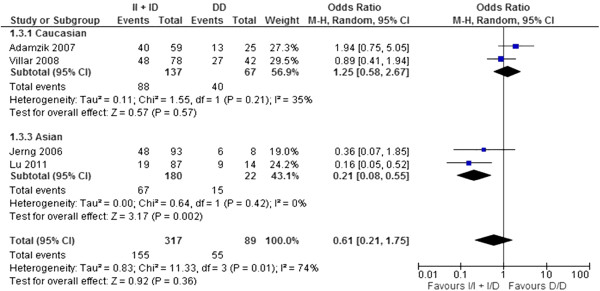
Forest plot of OR with 95% CI forACEI/D polymorphism in ALI/ARDS mortality: recessive model.